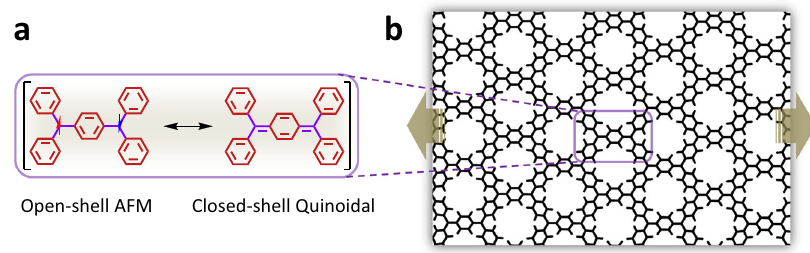
Fig. 1 Bi-radical integration in 2D-CORFs. a Schematic representation of the energetically close resonant valence bond forms in the ground state of Thiele ’ s bi-radical: the open-shell AFM (left) and the closed-shell quinoidal (right). b 2D-CORFs viewed as extended 2D analogues of bi-radical compounds, where one could potentially switch between the two electronic states via external uniaxial strain (brown